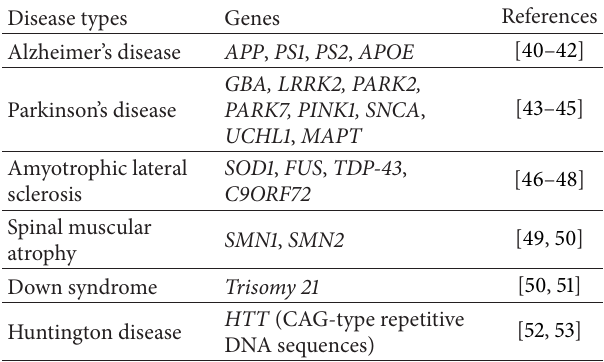
Table 2: Associated genes in patients with neurodegenerative